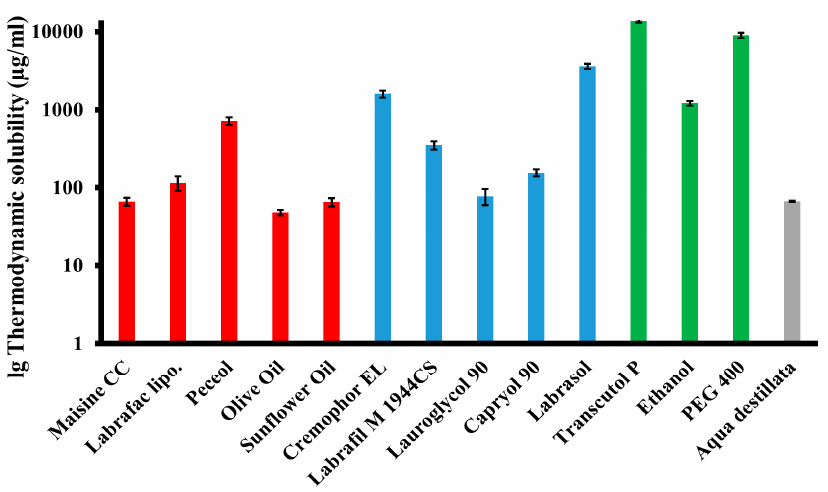
Figure 1. Thermodynamic solubility of baicalin in various oils (red), emulgents (blue), co-emulgents (green), and distilled water (gray). (Mean ± SD; n = 3).